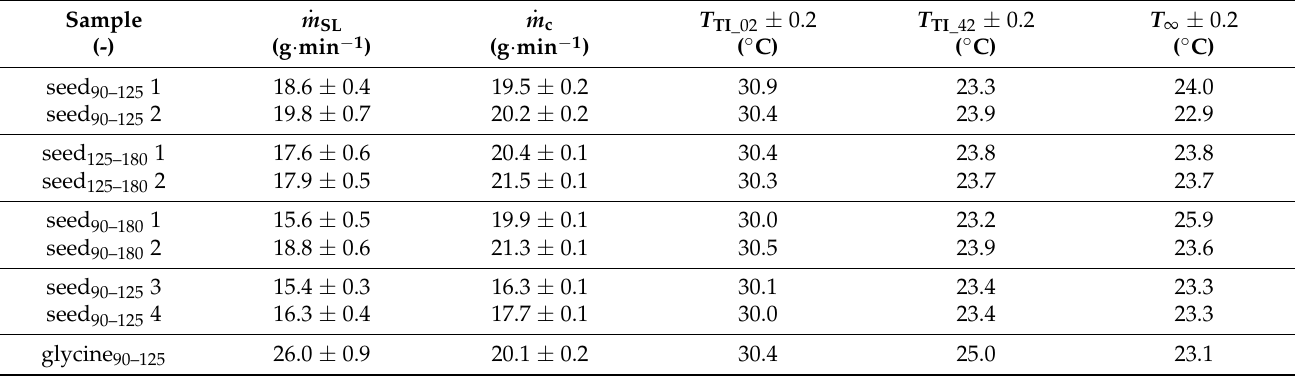
Table A3. Crystal growth experiments’ process